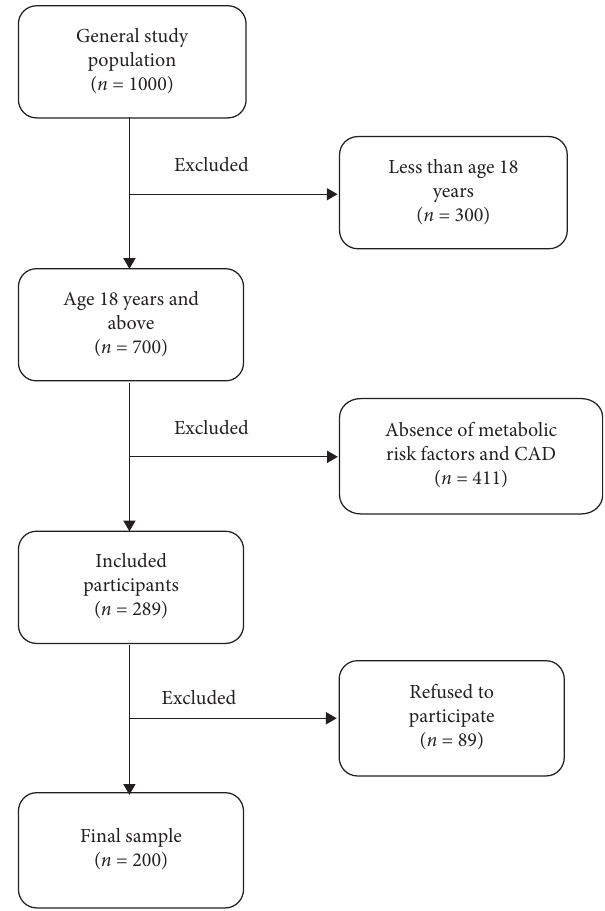
Figure 1: Flowchart for participants selection.